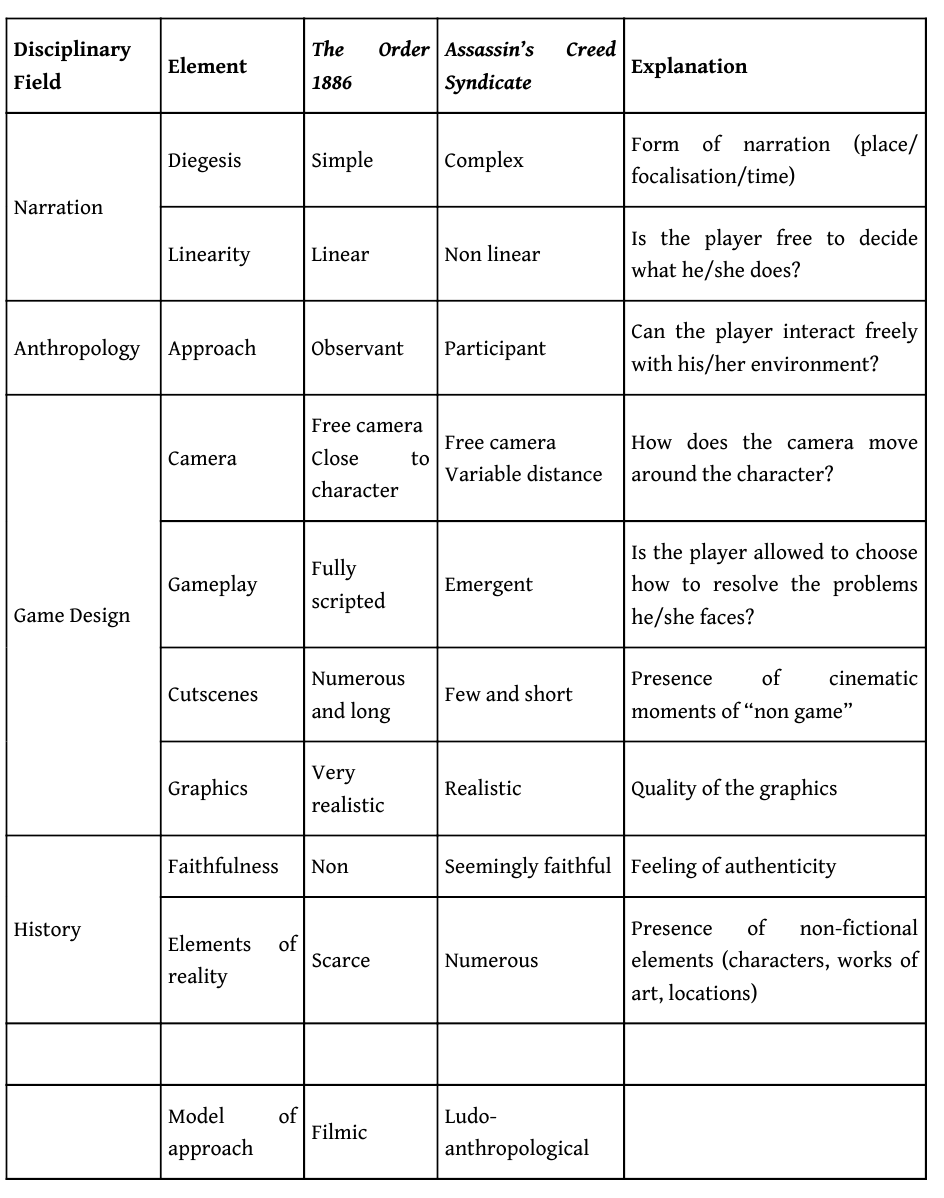
Table : Synthesis of the two models of historical games